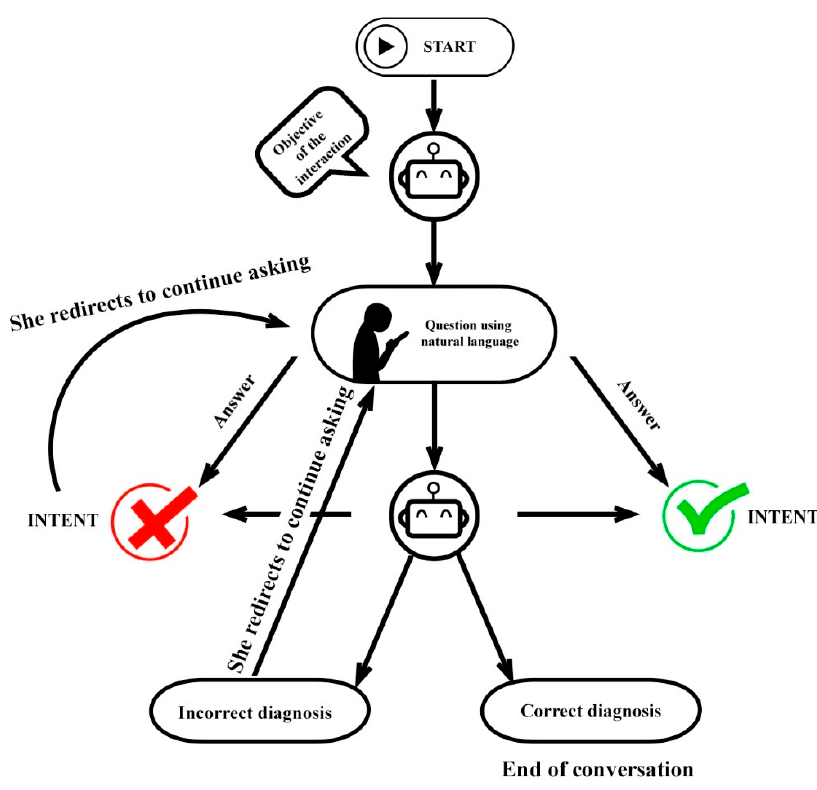
Figure 3. Data flow diagram.